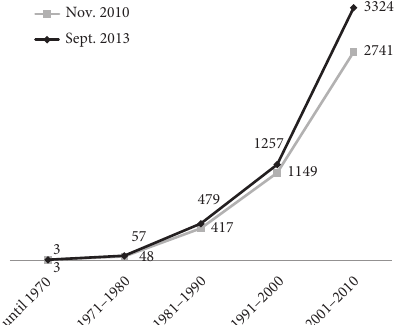
Fig. 2. Evolution, per decade, of numbers of DSS materials indexed in ScienceDirect